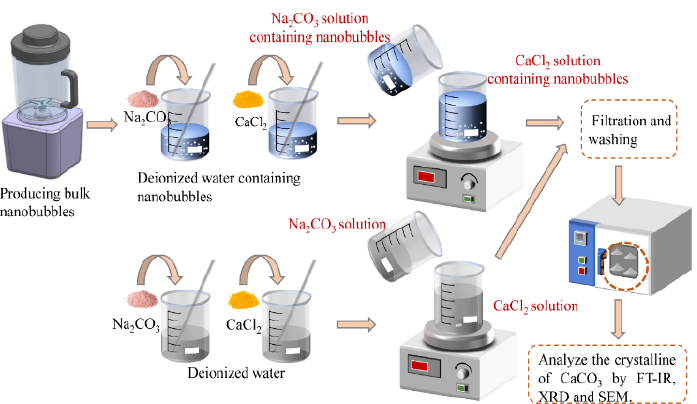
Figure 1. The flow chart of the synthesis of CaCO 3.